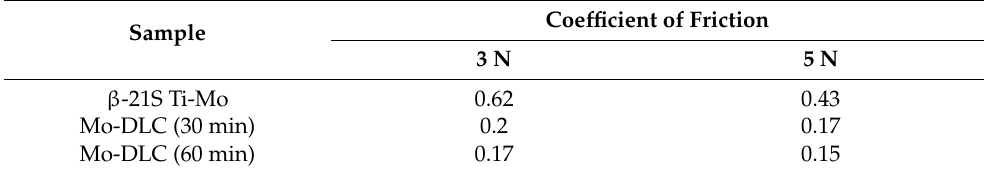
Figure 12. Coefficient of friction as a function of time for ( a ) 3N and ( b ) 5 N loads on Mo-DLC coatings and bare β -21S Ti-Mo alloy substrate. Table 2. Coefficient of frictions of Mo-DLC coatings on β -21S Ti-Mo substrate.